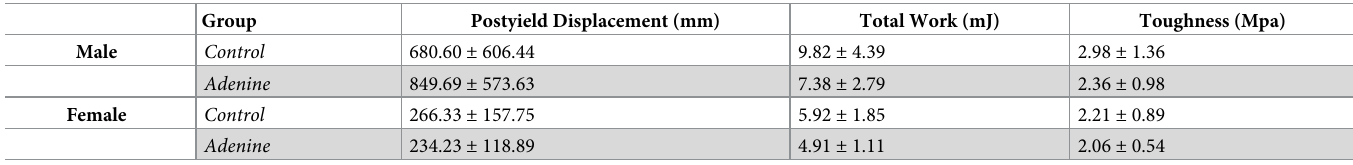
With only adenine mice of both sexes, kidney crystals did not predict serum BUN (R 2 = 0.251, p = 0.068) or cortical porosity (R 2 = 0.099, p = 0.274)), but did significantly predict serum PTH levels (R 2 = 0.403, p = 0.015). With both sexes of control and adenine mice combined, Table 1. Mechanical properties from 3-pt-bend test of the